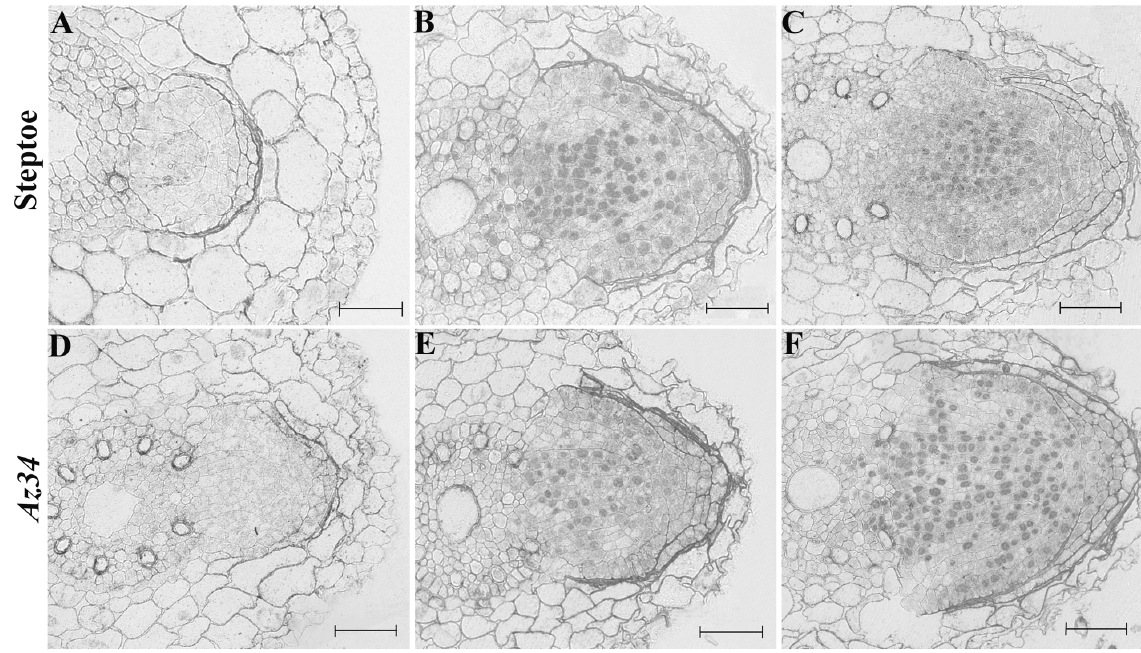
Figure 2. Immunostaining of IAA in root primordia of Steptoe ( A – C ) and Az34 ( D – F ) at successive stages of their development. Scale bar is 50 µm.